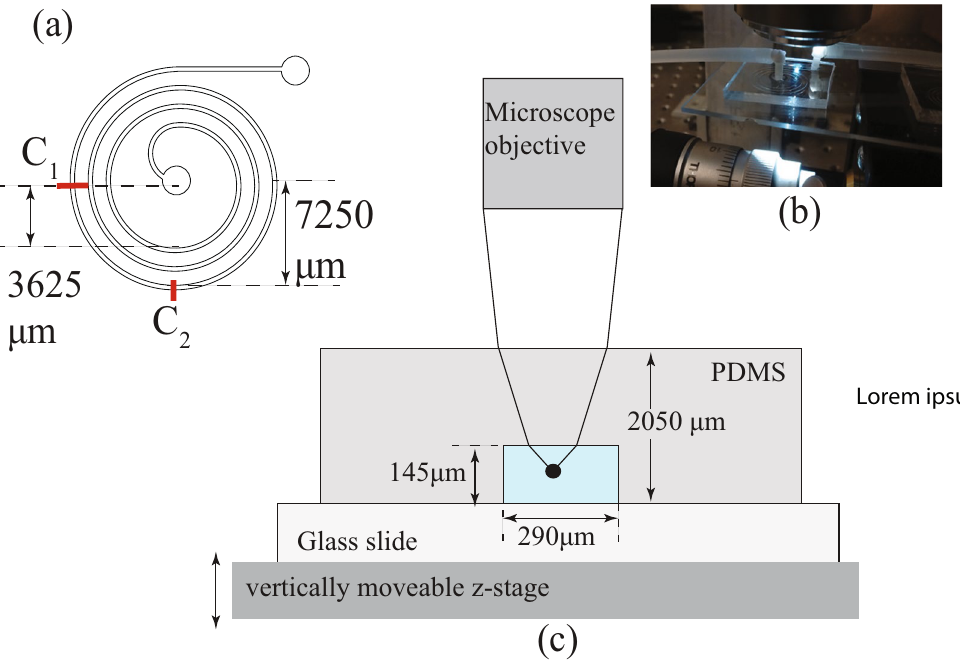
Figure 1. Experimental setup. ( a ) Top view of the spiral microchannel with the inlet at the center, ( b ) a sample device, ( c ) schematic of the cross section of the device and refracting light rays that travel to the objective lens of the microscope The geometry of the device in (c) is not to scale. The particle images in the channel are recorded at section C 1 on the last spiral arm in (a).